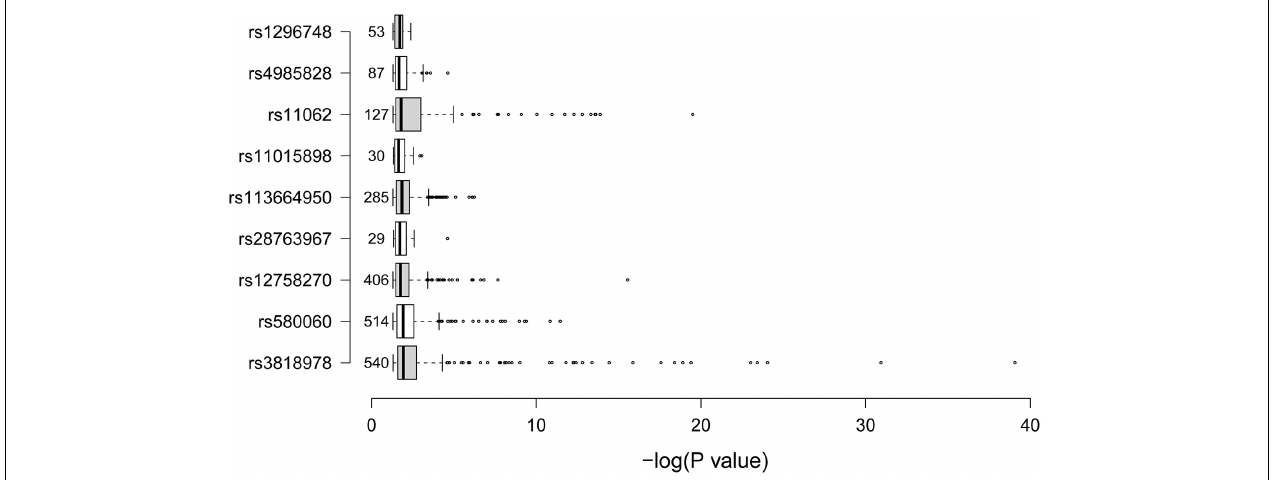
FIGURE 2 | Summary of the expression quantitative loci (eQTL) signals. The boxplot summarized the –log 10 p -values for the eQTL signals of the nine spontaneous coronary artery dissection (SCAD)-associated RNA modification single-nucleotide polymorphism SNPs. The data were obtained from the GTEx project. The numbers on the left side of the boxes were the number of eQTL signals for the corresponding